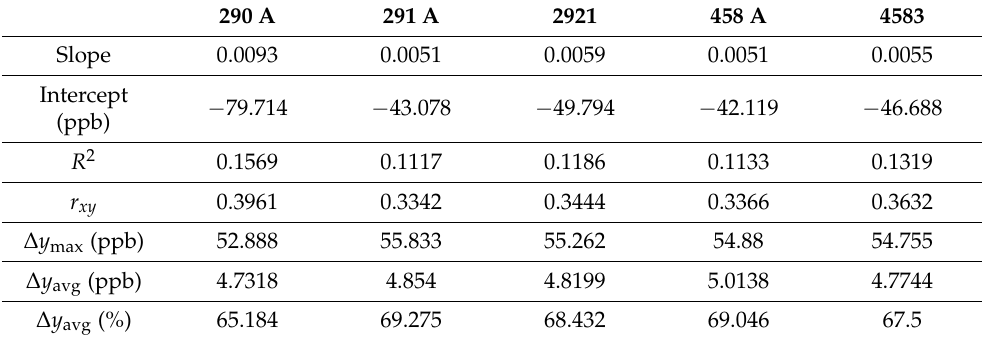
Table 8. Calculated values for data analysis of NO sensors.